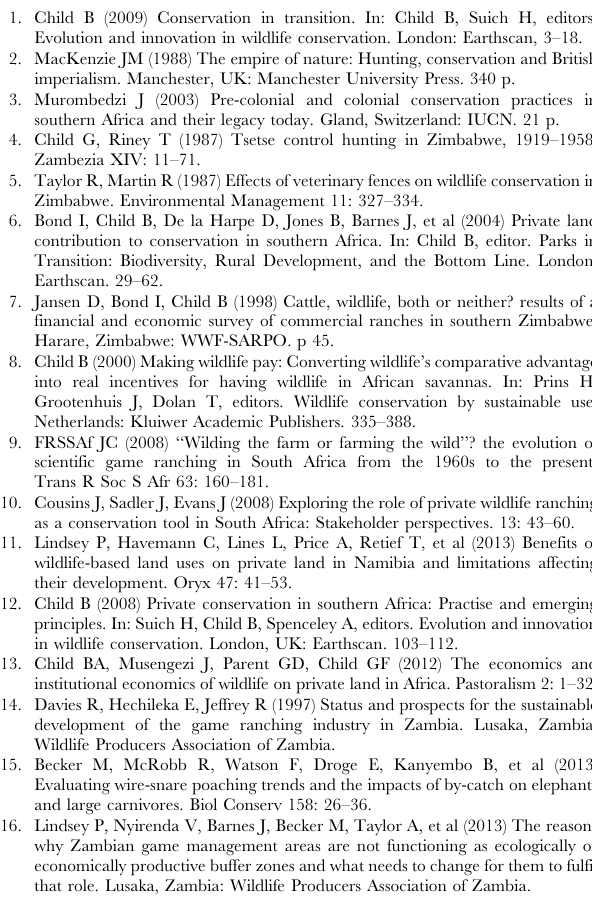
Table S2 Schedule of typical initial capital expenditures needed at start-up on a 20 km 2 game section, (USD 2012) (assuming that no wildlife was present at all, and a wide range of ungulate species were reintroduced). Table S3 Schedule of typical annual variable and fixed cost expenditures needed for the small-scale fenced game ranch model during year 20 of project life (USD